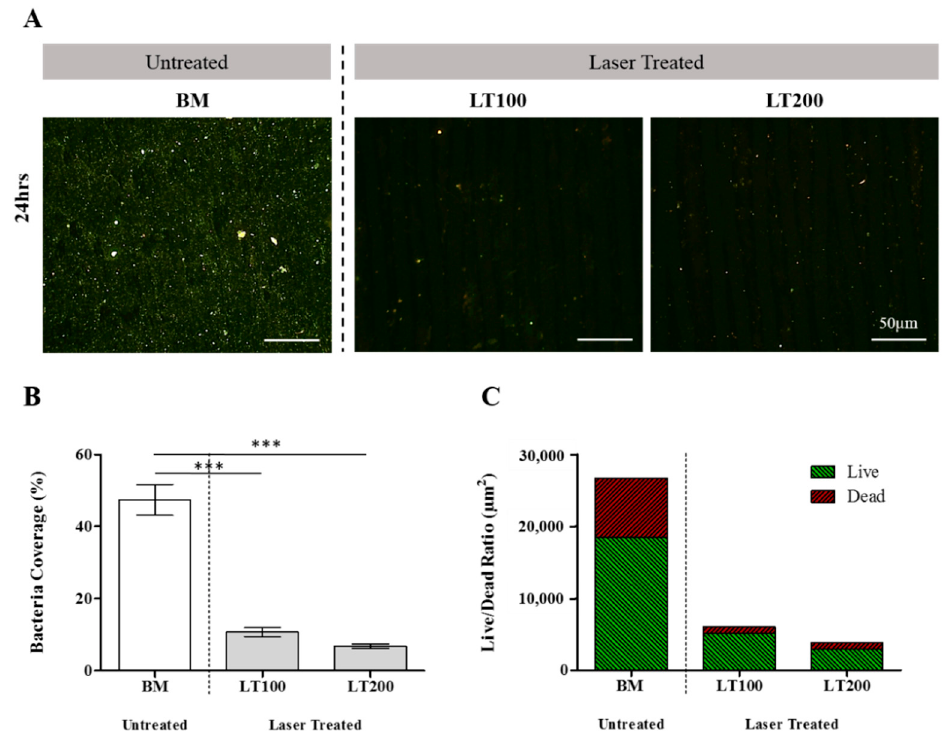
Figure 8. Bacterial adherence significantly reduced with laser surface treatment. ( A ) Merged fluorescence images of bacteria at 24 h using live/dead staining. Scale bar = 50 µ m. Images are representative of bacteria coverage on the entire surface. ( B ) Total bacteria coverage measured from fluorescence microscopy. Error bars are the SE of n = 24. The total bacteria coverage refers to the total sum of red and green areas present after cell staining. ( C ) Live-to-dead ratio of bacteria cells measured from fluorescence microscopy on the surfaces post staining, based on average red and green areas per group. Data calculated in both graphs using twenty four images per surface at each time point using ImageJ software.